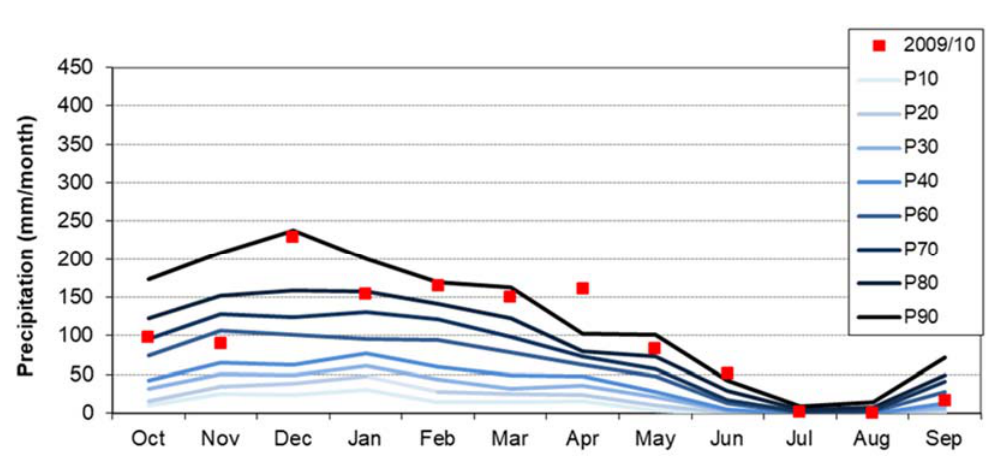
Figure 2. Monthly precipitation percentiles between 1938/39 and 2009/10 and monthly precipitation during the hydrological year of 2009/10 (red squares), in São Julião do Tojal Station.